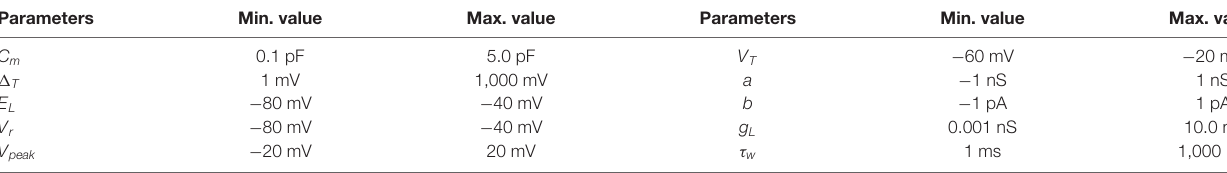
TABLE 1 | Model parameter ranges established for the search space of the optimization process.